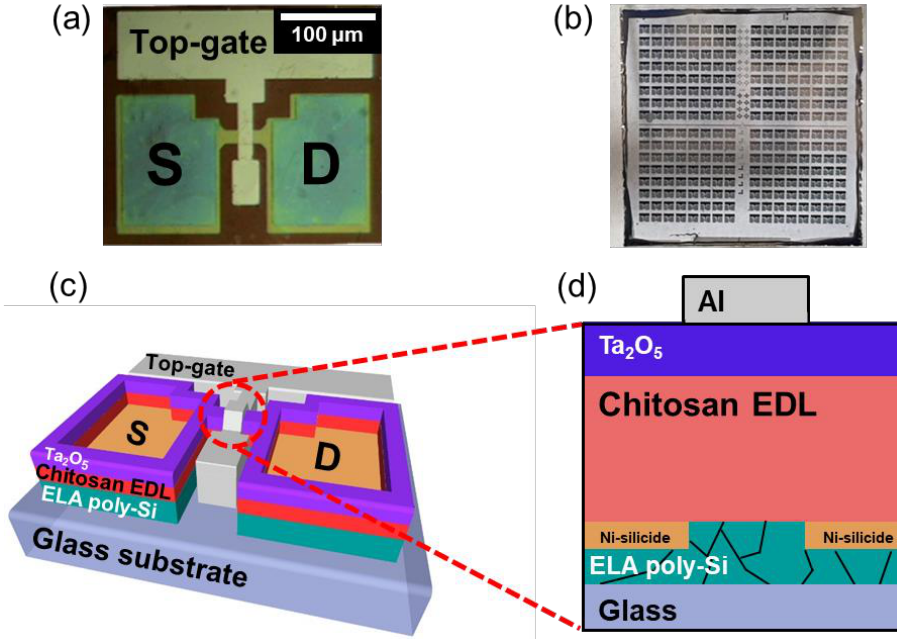
Figure 1. ( a ) Optical microscopic image of the ambipolar chitosan synaptic transistor with Ni-silicide (NiSi) source/drain (S/D) and ( b ) photographic array images of the ELA glass substrate. Schematics of the ( c ) three-dimensional and ( d ) cross-sectional structure of the synaptic transistor.